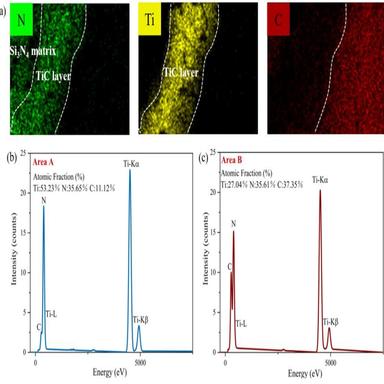
Element distribution and XRD patterns at the interface: (a) the distribution of N, Ti, and C at the interfaces, (b) EDS at Area A shown in b), and (c) EDS at Area B shown in b).